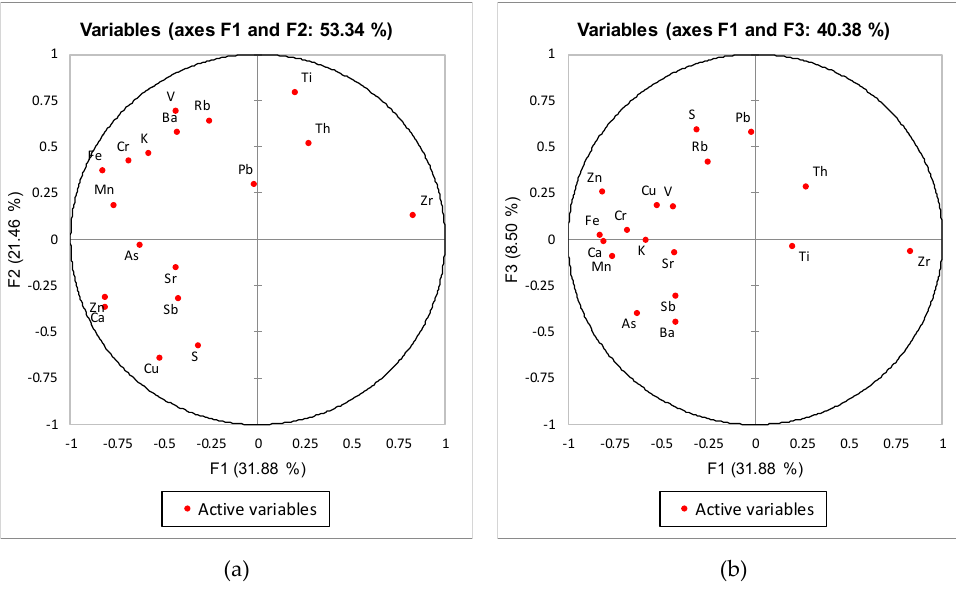
Figure 10. PCA factor diagrams for F1-F2 ( a ) and F1-F3 ( b ). Samples from group Ah, pXRF clr data.